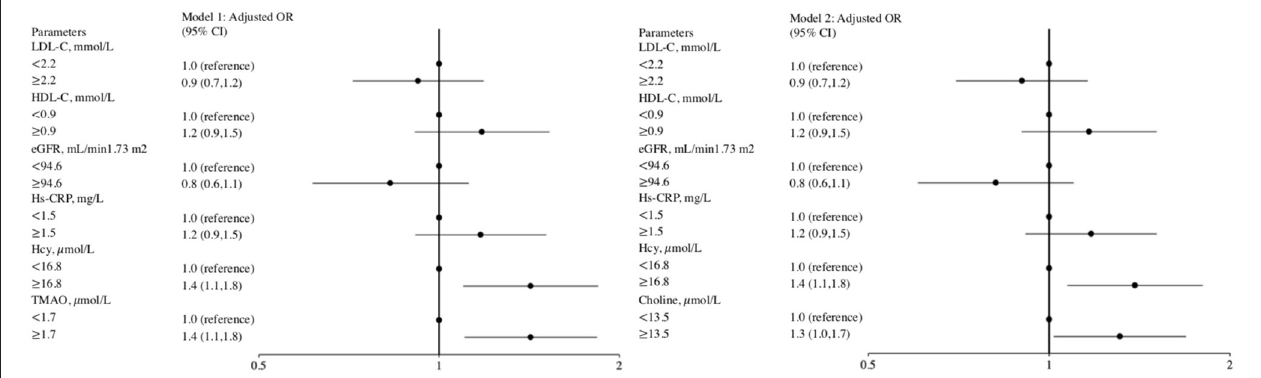
FIGURE 2 | Forest plot of the ORs for potential biomarkers with severe total WMH risk. The odds ratio was calculated according to the median value of potential biomarkers’ levels using ordinal logistic regression models. The bar represents 95% confidence interval (CI). Model 1 included age, sex, hypertension, diabetes mellitus, prior stroke or transient ischemic attack, history of anti-platelet, lipid-lowering, or anti-hypertensive agents, BMI (body mass index), systolic blood pressure, low-density lipoprotein cholesterol, estimated glomerular filtration rate, homocysteine, and high sensitive-C-reactive protein and TMAO as covariates. Model 2 included age, sex, hypertension, diabetes mellitus, prior stroke or transient ischemic attack, history of anti-platelet, lipid-lowering, or anti-hypertensive agents, BMI, systolic blood pressure, low-density lipoprotein cholesterol, estimated glomerular filtration rate, homocysteine, and high sensitive-C-reactive protein and choline as